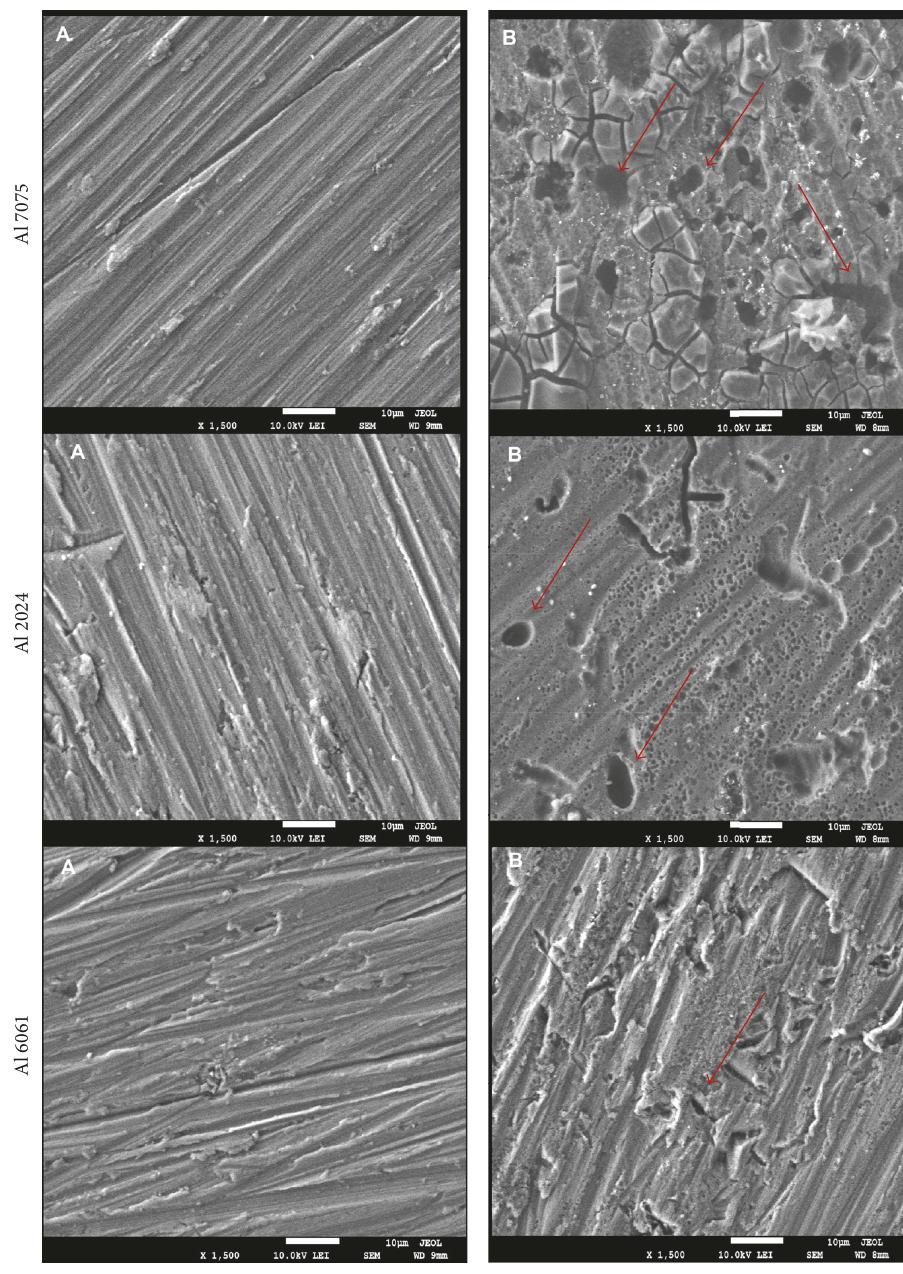
Figure 13: SEM images of Al 7075, Al 2024, and Al 6061 “A” before and “B” after being immersed in the Red Sea water for 5 weeks. The arrows indicate the